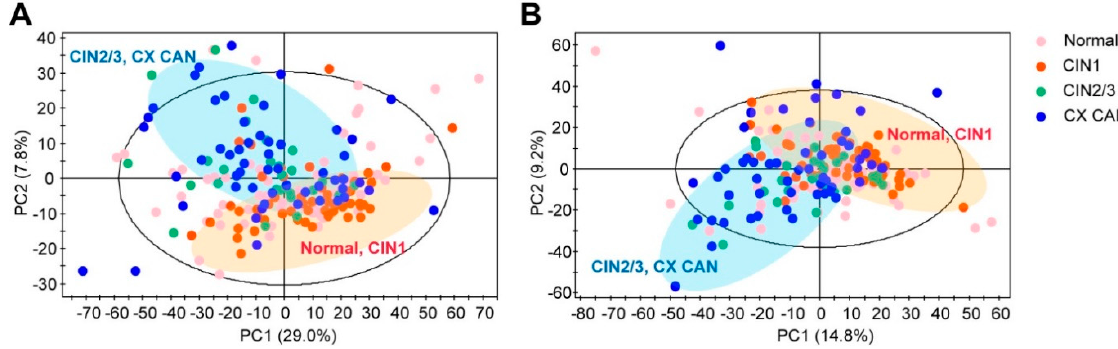
Figure 1. Score plots of principal component analysis (PCA) from metabolite spectra of ( A ) positive